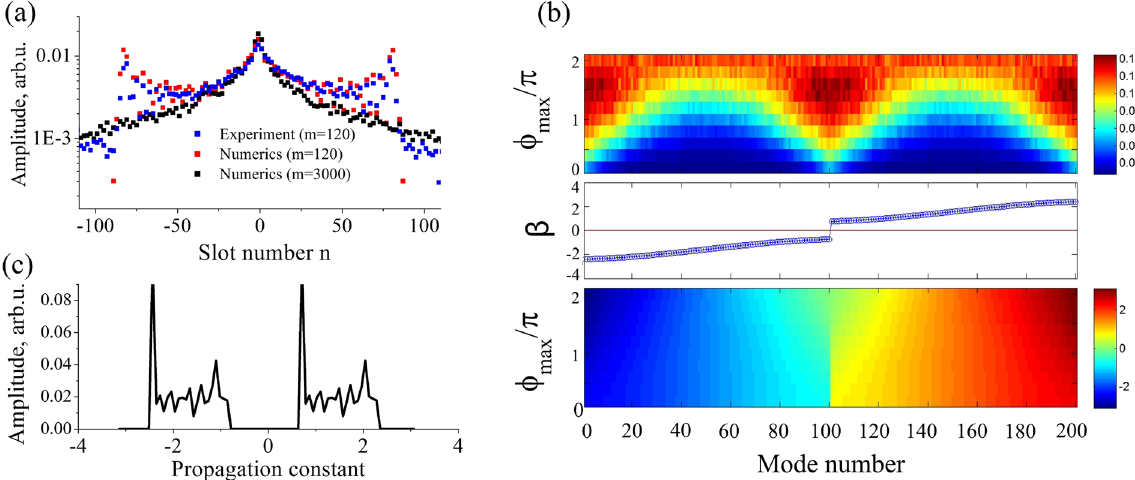
Figure 4. ( a ) Amplitudes of the pulse sequence propagating through the SPL with random potential strength = 0.2 π , in experiment and numerical simulations. Data is averaged over 100 different random realizations. φ max ( b ) Calculated inverse participation ratio for eigenmodes (upper panel), and the corresponding propagation constants β (lower panel) vs. the disorder strength ( φ max ). Middle panel shows the band structure for a trivial potential with φ max = 0. ( c ) An eigenmode excitation spectrum for a single realization of a SPL with random potential of strength φ max = 0.2 π , excited by a single